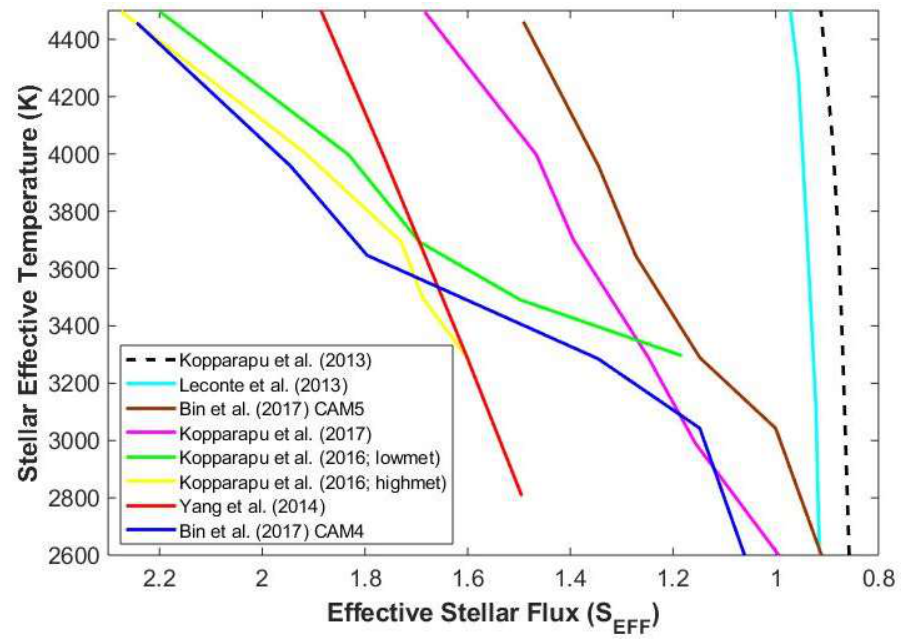
Figure 14. Summary of recent 1D and 3D model estimates of the location of the inner edge for mid-K- to M-stars. The Leconte et al. [25] curve is the nominal inner edge estimate for rapidly-rotating planets, superseding the previous estimate [26]. The remaining limits are various 3D estimates for synchronously-rotating worlds.